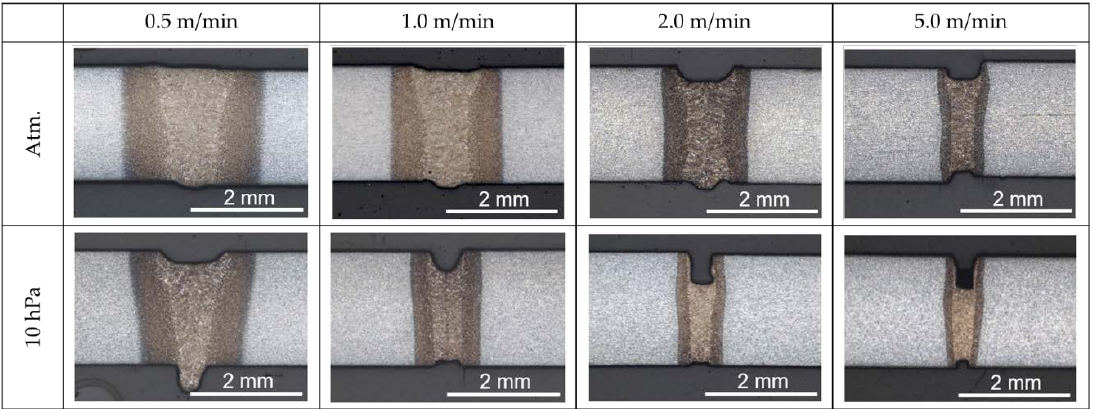
Figure 3. Macrographs of the specimens prepared with 0.2 mm gap, performed with different welding speeds at atmospheric pressure and 10 hPa.